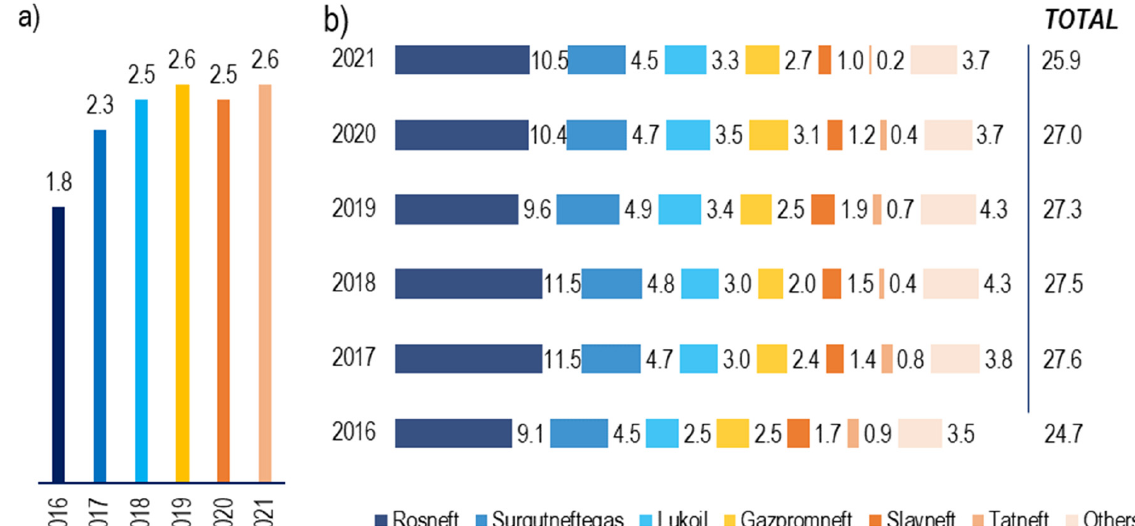
Figure 2. Drilling indicators from 2016 to 2021: ( a ) the costs of prospecting and exploration drilling for hydrocarbons, billion USD without VAT; ( b ) production drilling by companies of the Russian Federation, million m [10–16].